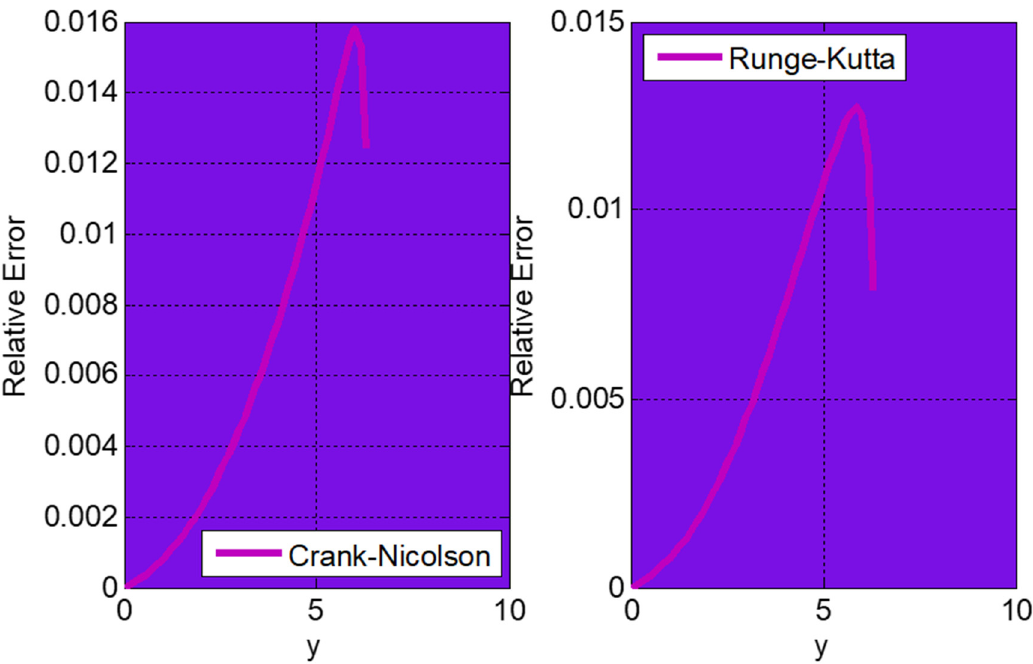
Figure 4. Comparison of two numerical schemes in time direction and proposed scheme in spatial direction for Stokes’ first problem using N y = 50, N t = 170, t f = 1.